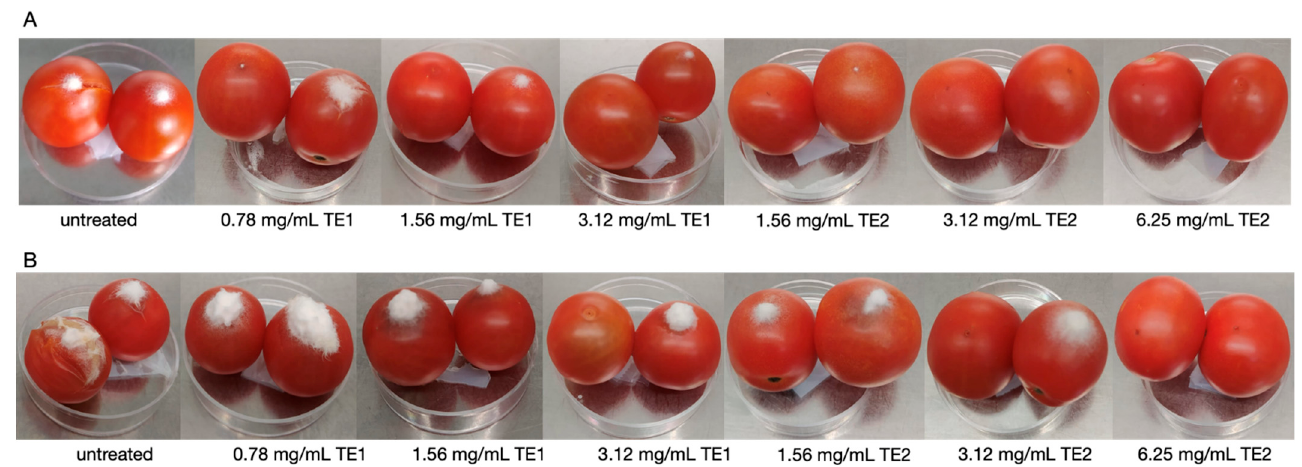
Figure 3. Mycelium growth of Fusarium verticillioides on tomato treated with TE1, TE2 and untreated at ( A ) 4 and ( B ) 11 days incubation.